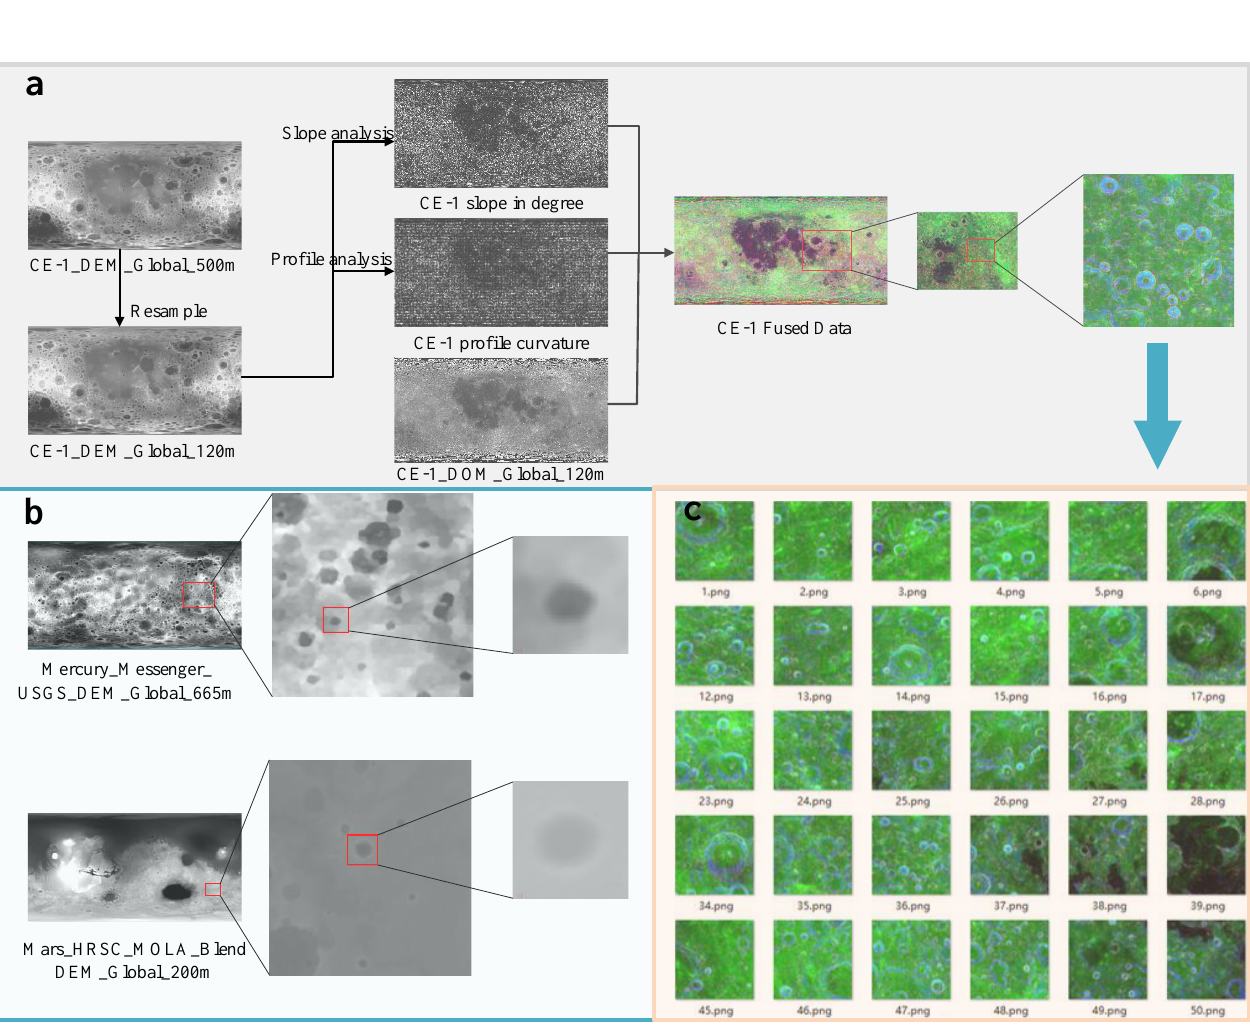
Figure 8. Deep space impact craters data: (( a ) CE-1 data fusion process. ( b ). Mercury and Mars DEM data. ( c ). The CE-1 fusion dataset).